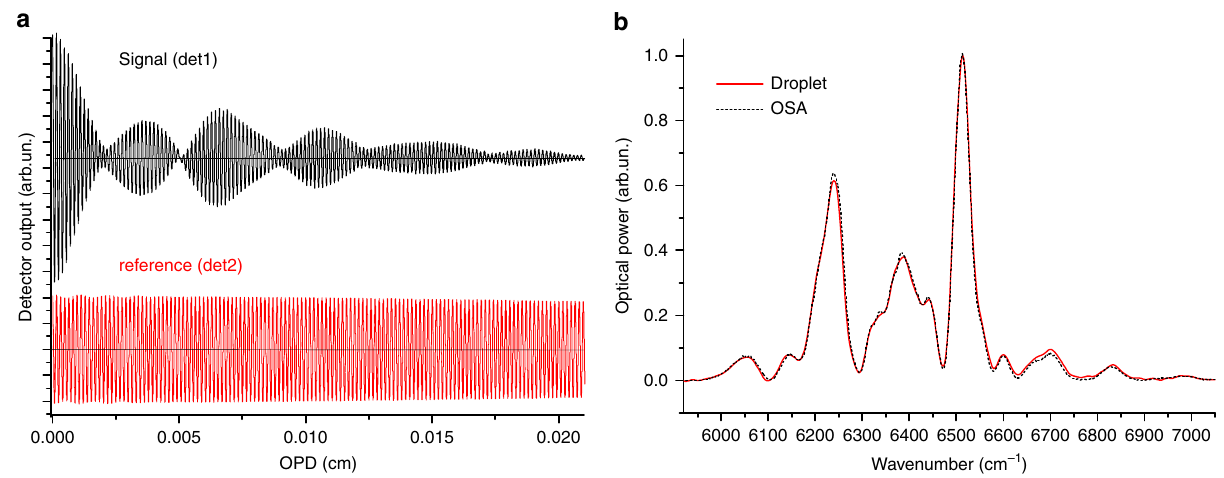
Fig. 2 Spectral analysis of a light source. a interferograms obtained from the raw signals of Fig. 1c after processing as in Eq. (2). For ease of visualization, the x scale span is limited to 0.02 cm; b red line: spectrum of a supercontinuum source obtained by discrete Fourier transform of the det1 interferogram (zero- fi lling factor = 4, no apodization, no phase-correction, Resolution = 11 cm − 1 ); black dashed line: same spectrum recorded with a commercial optical analyzer (8.5 cm − 1 resolution, 3-points adjacent averaging).